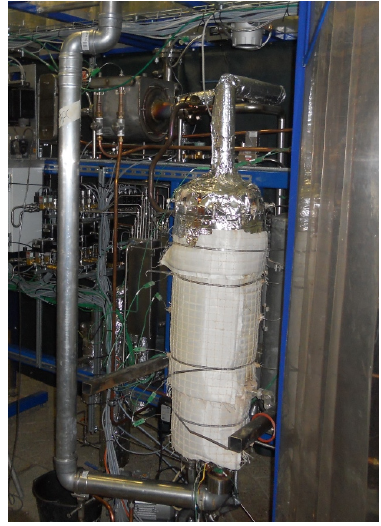
Figure 14. Picture of the prototype reactor for the Fischer ‐ Tropsch (FTS) process.